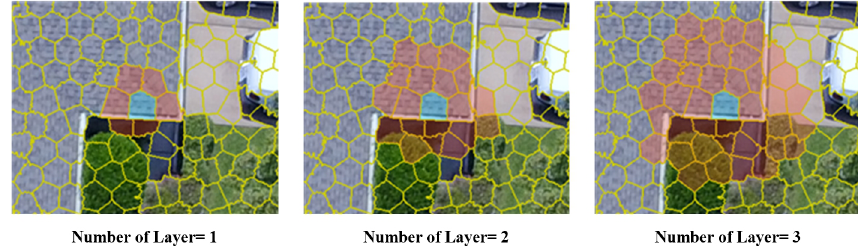
Figure 2. Superpixel community